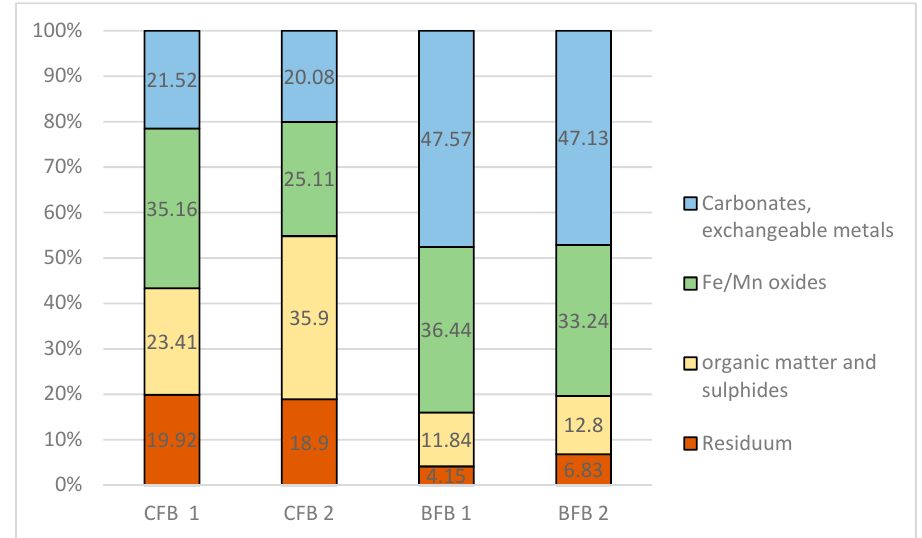
Energies 2020 , 13 , x FOR PEER REVIEW Figure 1. Speciation of cadmium in fly ash. Figure 1. Speciation of cadmium in fly ash.